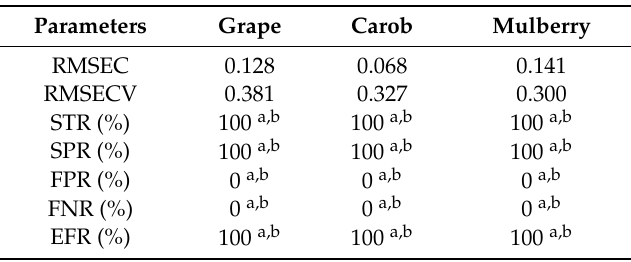
Table 1. PLS-DA classification parameters of grape, carob and mulberry pekmez samples. Parameters Grape Carob